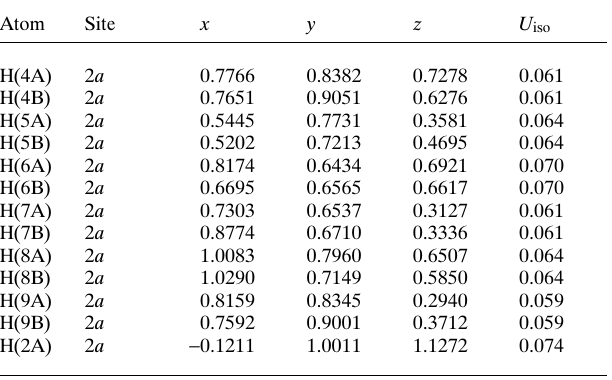
Table 2. Atomic coordinates and displacement parameters (in Å 2 )